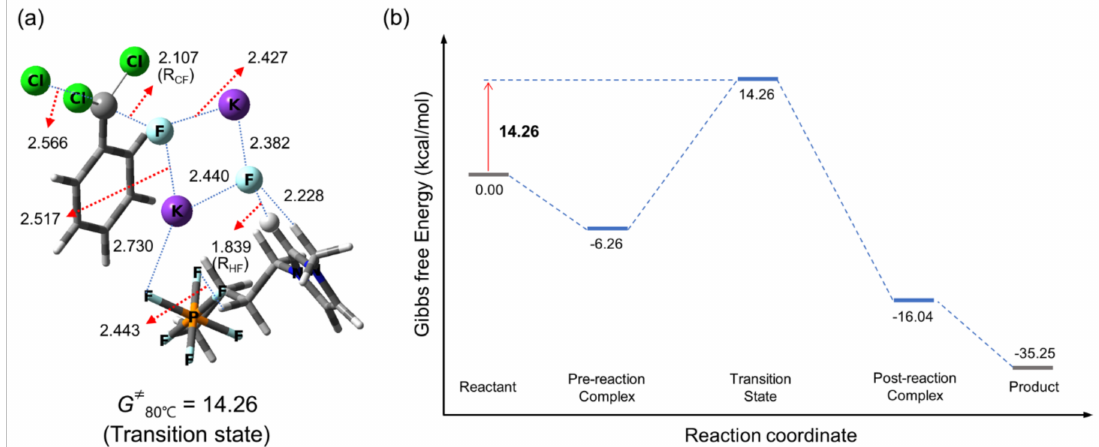
Figure 5. Calculated ( a ) transition state and ( b ) energetics of S N 2 fluorination in [bmim]PF 6 with substrate:KF = 1:2.